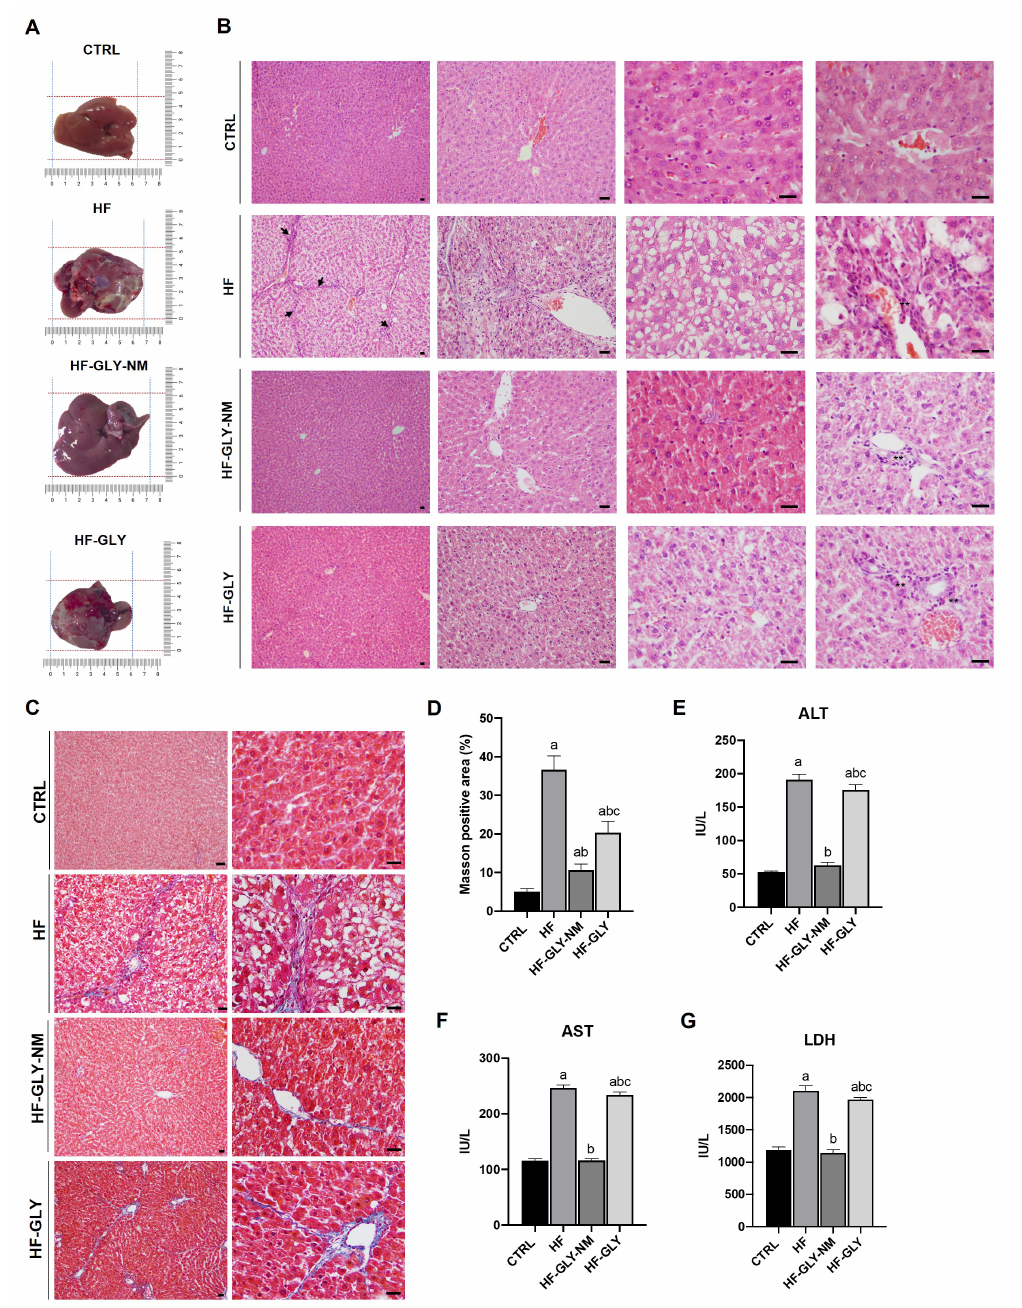
Figure 2. Effects of GLY and GLY-MNs on liver morphology and function. ( A ) Representative images of livers from CTRL (Group I), HF (Group VII), HF-GLY-NM (Group IX) and HF-GLY (Group X). ( B ) Haematoxylin and eosin staining of liver sections. Arrow indicates typical irregular shape of liver lobules during fibrosis (scale bar: 10 µ m). ( C ) Masson’s trichrome staining of liver sections (scale bar: 10 µ m). ( D ) Quantification of Masson’s trichrome positive areas. The amount of interstitial fibrosis was measured by quantifying the collagenous fibrotic areas stained in blue/green in 10 random liver fields per section from four different rats for each group. Images were analysed by using multiphase image analysis ImageJ with a software version 1.49s. Values are expressed as mean ± SD. ( E ) Alanine Transaminase (ALT), ( F ) aspartate transaminase (AST) and ( G ) lactate dehydrogenase (LDH) activities. Values are expressed as mean ± SD (n = 8). Significative values were reported with respect to Group I CTRL, a = p < 0.05; to Group VII HF, b = p < 0.05; to Group IX HF-GLY-NM, c = p <